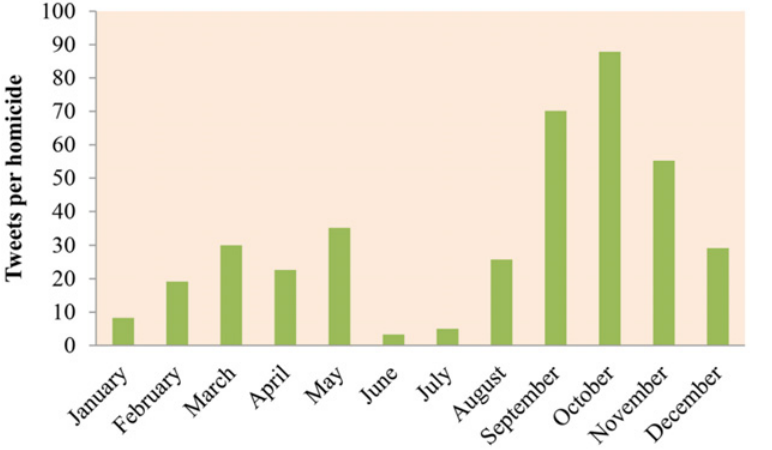
Fig 3. Homicide tweets ratio by month in